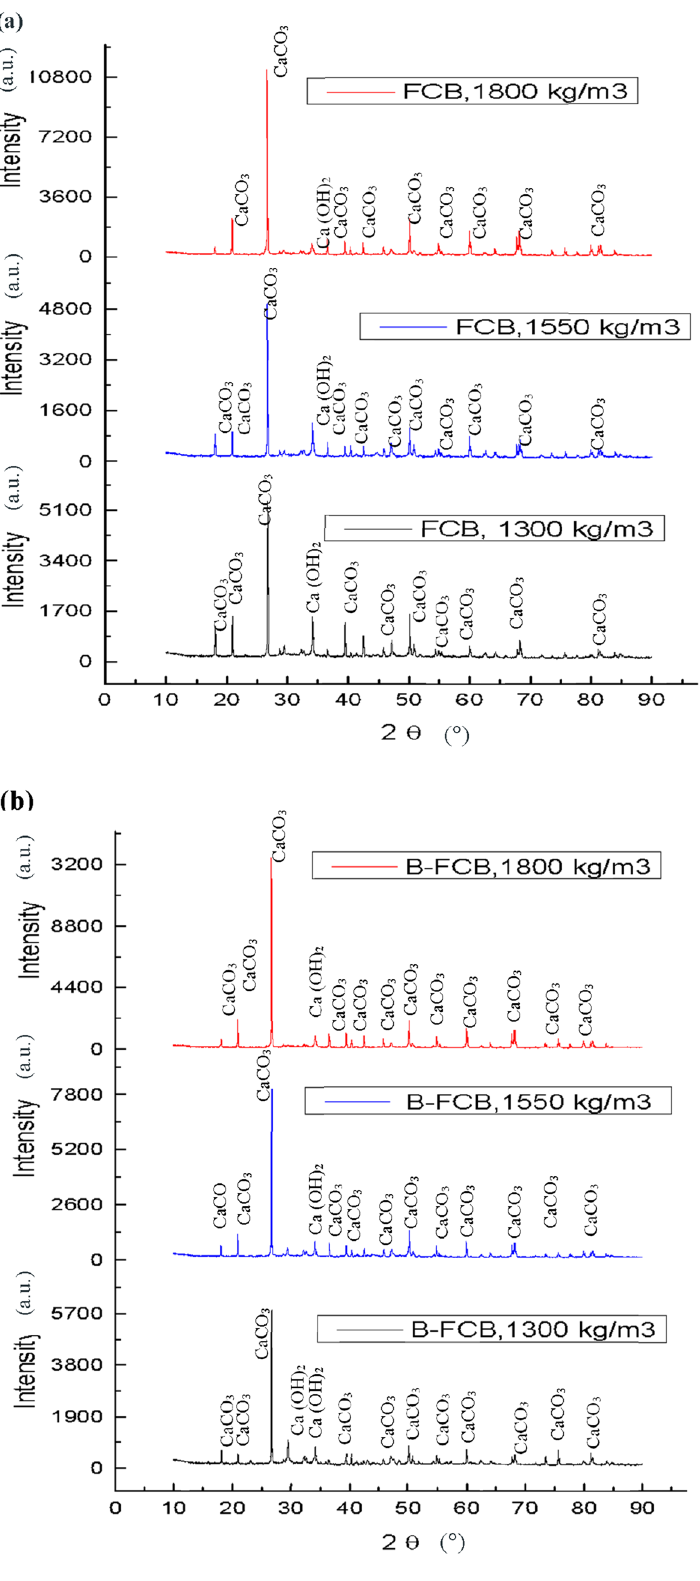
Figure 15. XRD spectra of produced precipitate CaCO 3 with different level of densities ( a ) FCB specimens ( b ) B-FCB specimens at 28